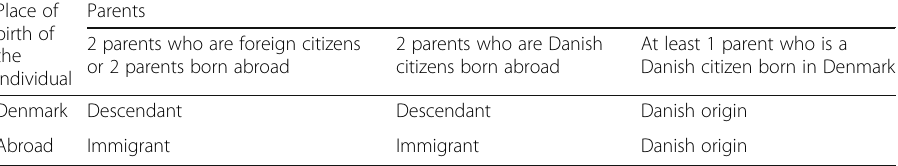
Table 2 Correspondence between concepts used by Statistics Denmark and the respective population groups